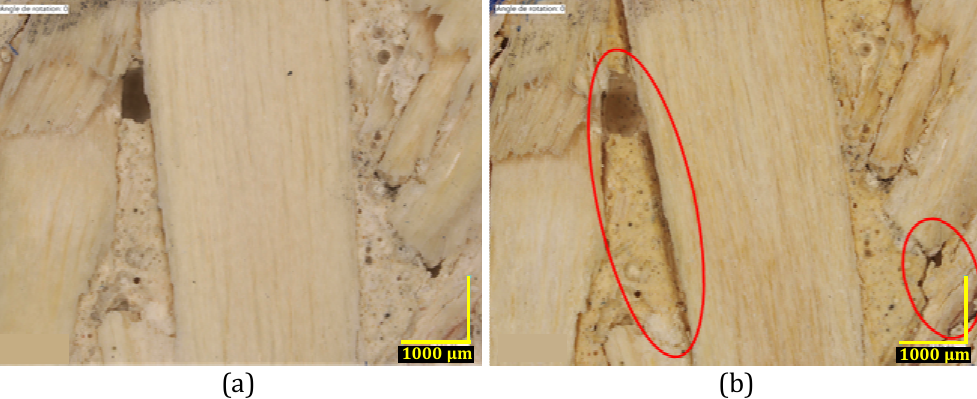
Figure 8. Photograph showing the effect of aging on the microstructure of hemp concrete: ( a ) reference hemp concrete; ( b ) aged hemp concrete.